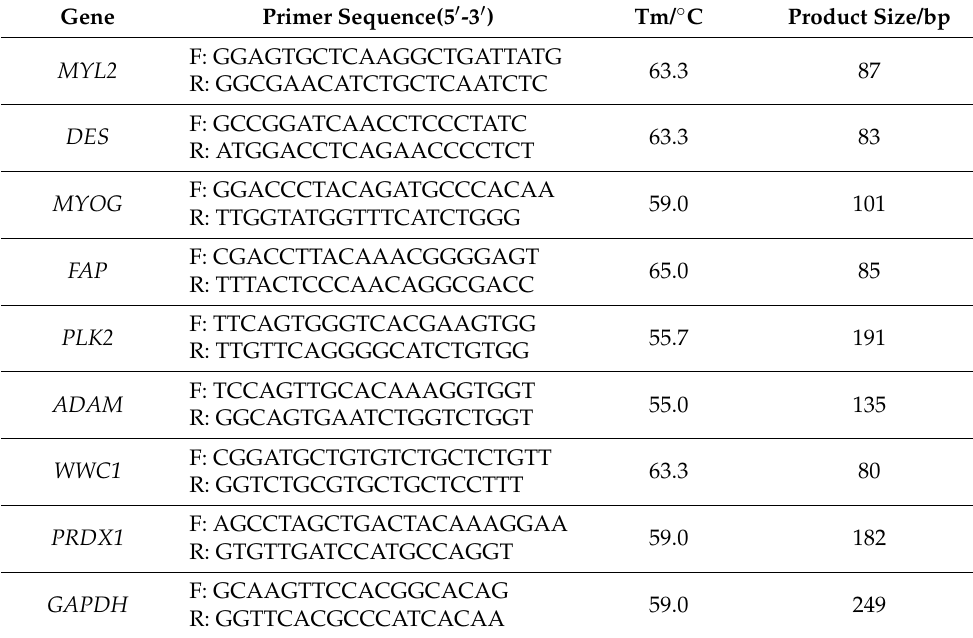
Table 1. Primer sequences for qRT-PCR validation.